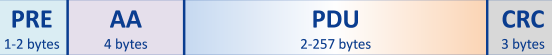
Figure 9. BLE packet structure. The packet has one or two bytes of PRE, depending on the radio data rate, four bytes of AA, from two to 257 bytes of PDU and three bytes of CRC.